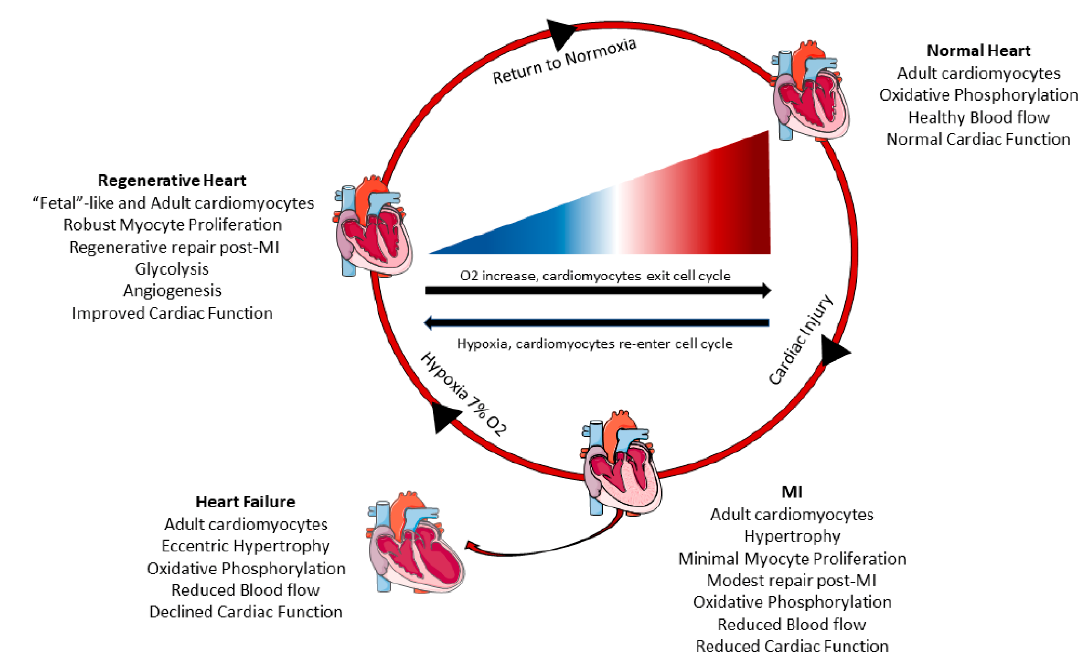
Figure 2. Systemic hypoxia can induce cardiomyocyte proliferation and cardiac regeneration. Healthy adult hearts have normal cardiac function, blood flow, and utilize oxidative phosphorylation to generate energy. Following myocardial infarction (MI), there is increased cardiomyocyte hypertrophy, scar formation, reduced cardiac pump function, and minimal cardiomyocyte proliferation. These adverse changes can progress and lead to heart failure overtime with increased dilation of the myocardium, poor blood circulation, and declined cardiac function. However, a recent study in mice [51] demonstrated that systemic hypoxemia post MI caused cardiomyocytes to undergo a metabolic switch from oxidative phosphorylation to anaerobic glycolysis. Hypoxia also enhanced cardiomyocyte proliferation and hypoxic myocytes resembled fetal cardiomyocytes. Hypoxic mice had increased angiogenesis, reduced scar size, and improved cardiac function. When the mice returned to normoxia, cardiac repair and elevated cardiac pump function was sustained.